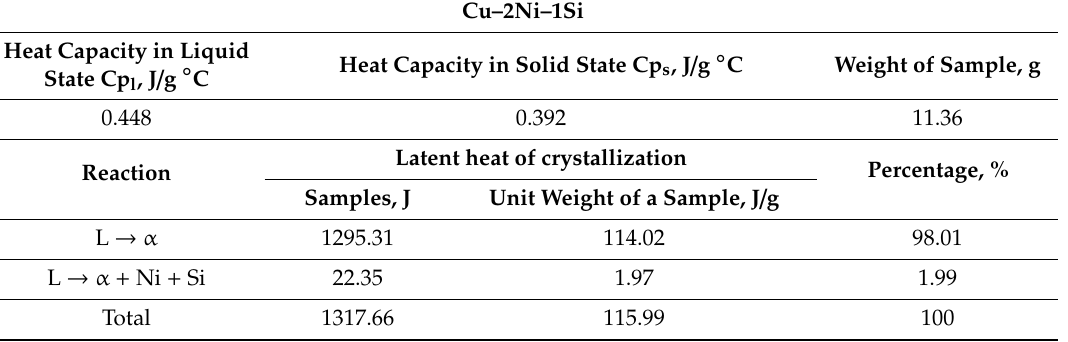
Table 4. Latent heat of crystallization produced by phases and its percentage in the total heat of crystallization of Cu–2Ni–1Si–0.6Re alloy.